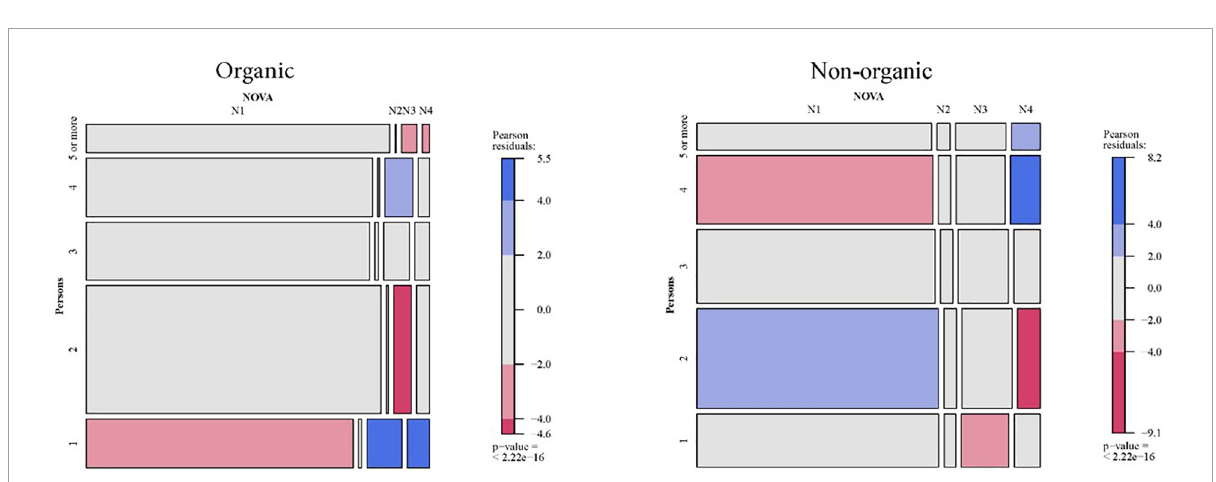
FIGURE7 Relationship between the number of persons in the household and NOVA: Organic vs. non-organic food purchases.